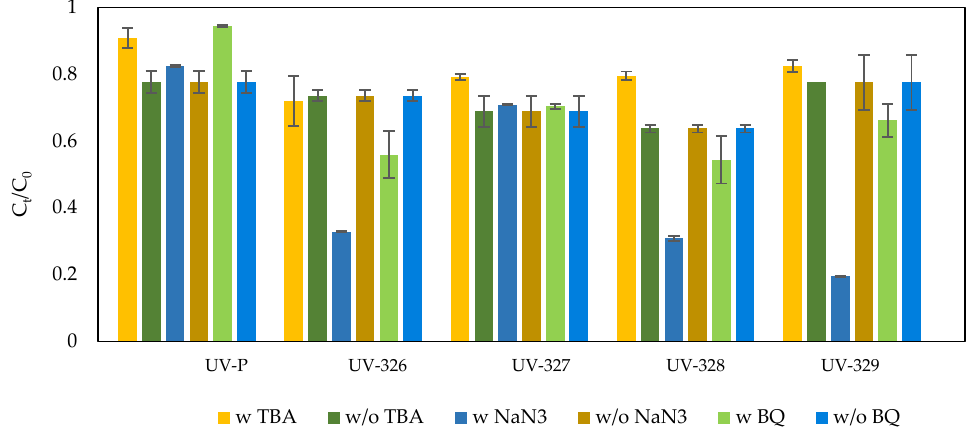
Figure 7. Effect of radical scavengers on UV stabilizers’ degradation in the Co 2+ /PAA process (w”— reaction with radical quencher, w/o”—reaction without radical quencher). There are two main sources of hydroxyl radicals in the Fe 2+ /PAA process. • OH radicals are formed from the direct reaction of PAA with iron ions and from the Fenton reaction taking place in the system, due to the presence of H 2 O 2 . The much higher reaction rate constant for the formation of radicals from peracetic acid at pH of 3.0–7.1 (0.5–1.10) × 10 5 M − 1 ·s − 1 , compared to that of Fe 2+ /H 2 O 2 (k = 63–76 M − 1 ·s − 1 ), proves that PAA decomposition is the predominant source of • OH radicals in Fe (II)/PAA systems [54]. As seen in Figure 1, the oxidation process of benzotriazoles takes place with a small share of hydroxyl radicals. Sodium azide, used as 1 O 2 quencher, increased the removal efficiency for almost all benzotriazoles. This phenomenon can be explained by the fact that at pH of 4–13, the N 3 − ion can react with hydroxyl radicals to form azide radicals N 3• , which, in turn, could oxidize organic compounds by electron transfer [77]: • OH + N 3 → OH − + N 3• (13) In the Co 2+ /PAA process, this phenomenon is not observed because fewer • OH radicals that can oxidize azide are produced. This result may, indirectly, prove the presence of hydroxyl radicals in the iron (II)-activated PAA system. Superoxide anion radicals can, also, be formed in the system, as a result of the reaction accompanying the Fenton process: